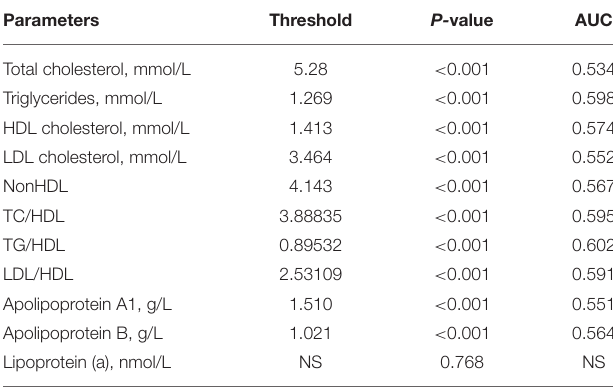
TABLE 2 | Determination of thresholds for each of the lipid parameters by continuous arterial stiffness index (ASI) values.